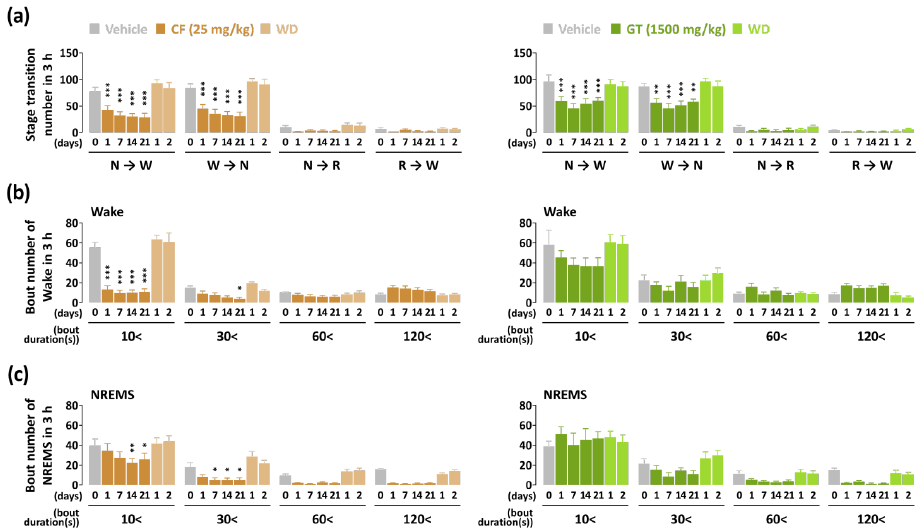
Figure 6. ( a ) Changes in stage transition number during the 3 h following caffeine (25 mg/kg) and GT (1500 mg/kg) treatments for the chronic administration period (21 days). Changes in the number of bouts of ( b ) wakefulness and ( c ) NREMS after caffeine and GT treatments during the chronic administration period (21 days). Grey bars illustrate the baseline day (vehicle). Brown and green bars illustrate caffeine and GT treatments, respectively. Light green and brown bars illustrate the withdrawal (WD) day after of GT and caffeine treatments, respectively. Every column denotes the mean ± SEM ( n = 7 – 8). * p < 0.05, ** p < 0.01, and *** p < 0.001 indicate significant differences compared to the vehicle (Dunnett’s test). CF, caffeine; GT, green tea ethanol extract; NREMS, non-rapid-eye- movement sleep; Wake, wakefulness; SEM, standard error of the mean.